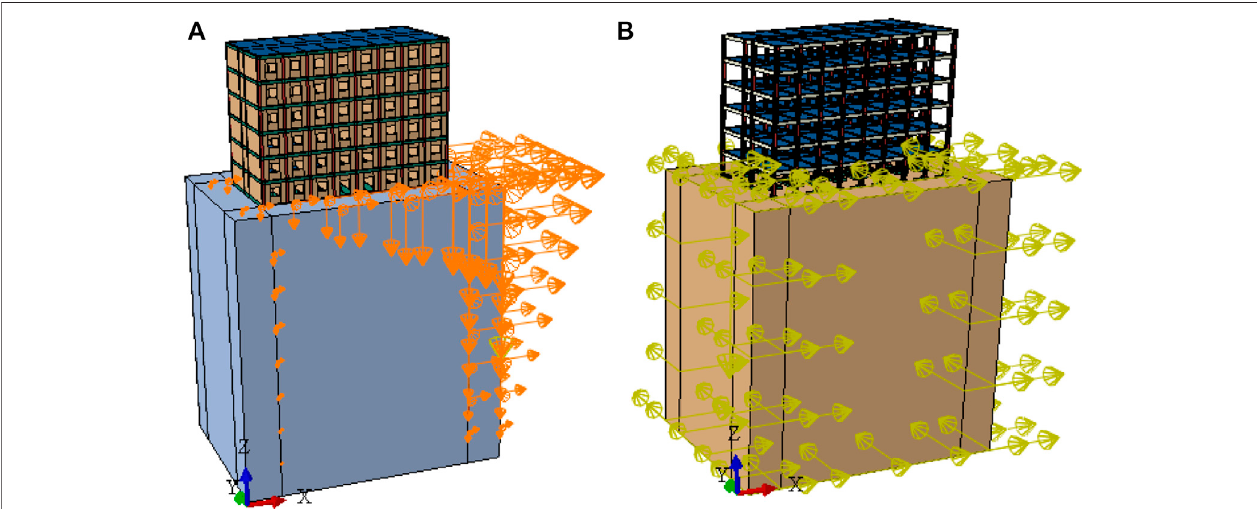
TABLE 1 | Material properties of building